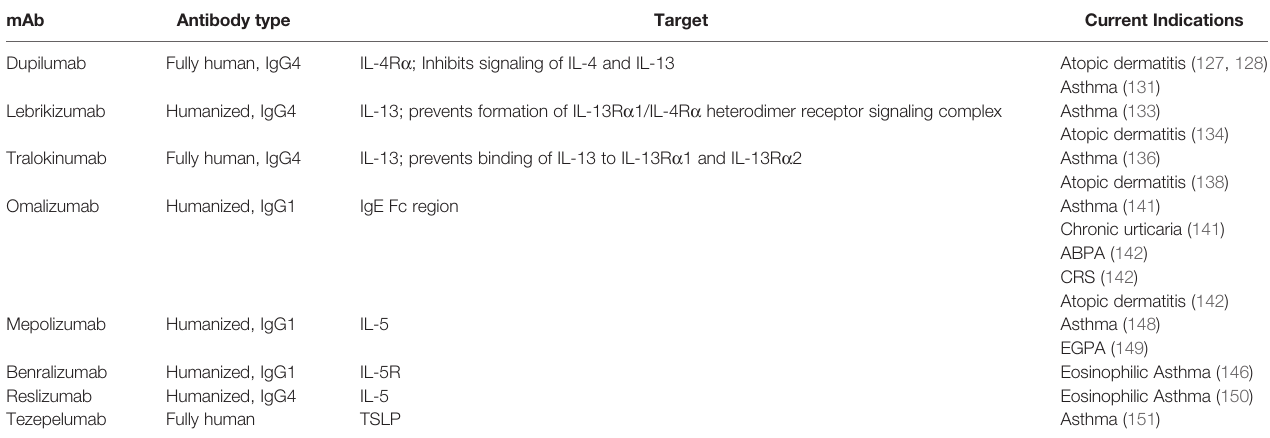
TABLE 2 | Select monoclonal antibodies with therapeutic potential in IgG4-related disease (IgG4-RD).